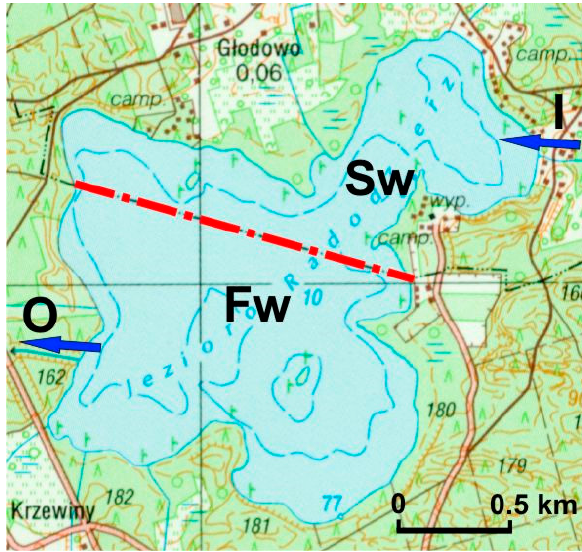
Figure 1. Division of Lake Rododzierz at variance with the Water Law. Sw—stagnant water. Fw—flowing water; I—inflow; O—outflow. Source: topographic maps in scale 1:50,000 (The National Geodetic and Cartographic Resources in Warsaw).